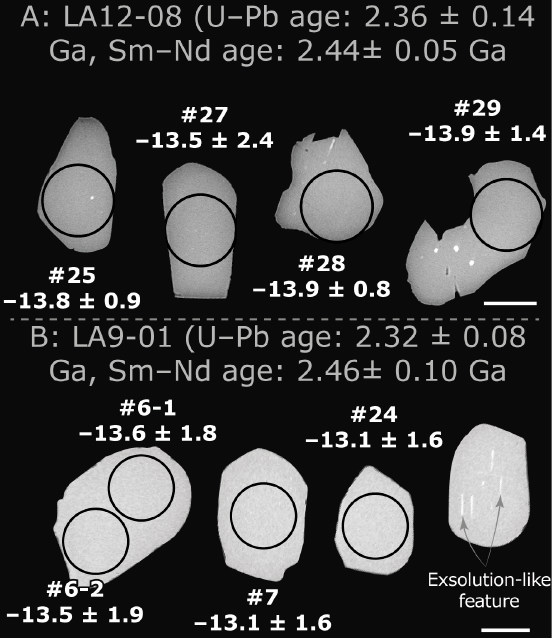
Figure 2. Representative BSE images of apatite crystals from the amphibolite facies grey gneiss LA12-08 (panel A ) and metatexite LA9-01 (panel B ). Scale bars represent 100 µ m. Spot size: 130 µ m. Labels represent analysis number (#) and ε 143 Nd initial deviation ± uncertainty at 95% confidence level calculated at the Sm–Nd isochron apparent age for each apatite